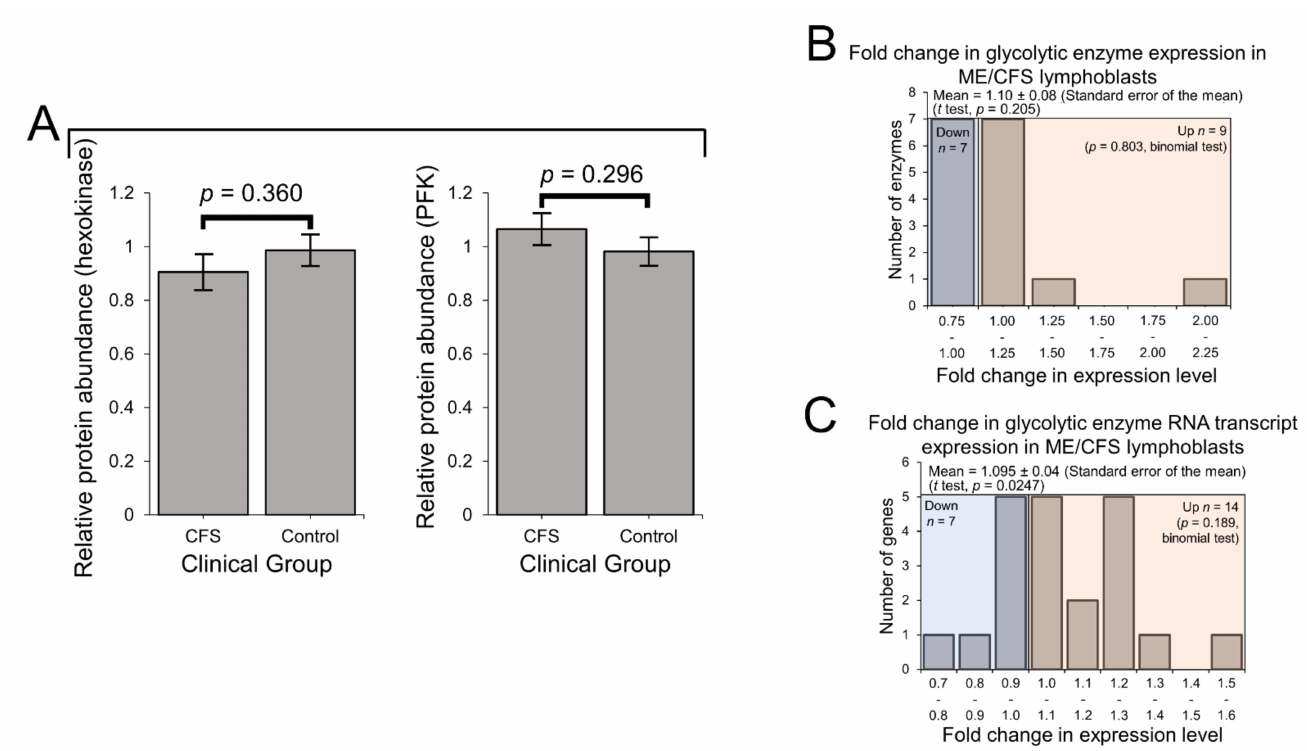
Figure 3. Protein-level expression of glycolytic enzymes is unchanged in Myalgic Encephalomyelitis/Chronic Fatigue Syndrome (ME/CFS) lymphoblasts. Error bars represent the standard errors of the mean. RNA sequencing transcriptomics experiment: ME/CFS n = 23, control n = 17. Each cell line was sampled once. Mass spectrometry proteomics experiment: ME/CFS n = 34, control n = 31. Each cell line was sampled once, or twice for a subset of healthy controls arbitrarily selected to act as an internal control between experiments in the proteomics work. ( A ) The expression level of hexokinase and phosphofructokinase is unchanged in whole-cell mass spectrometry proteomics experiments (independent t test ). Relative hexokinase (HK) and phosphofructokinase (PFK) abundance was calculated by averaging the mean fold change in the ME/CFS group for each isoenzyme/subunit of the respective enzyme (none of which were statistically significant on their own, threshold p < 0.05). ( B ) A total of 16 glycolytic enzymes were detected within the whole-cell proteomes of lymphoblasts from ME/CFS and control lymphoblasts. Fold change refers to the mean abundance of a given protein in the CFS group divided by the mean abundance in the control group. There was no significant difference in the differentially expressed proportions of detected glycolytic enzymes (binomial test with H o set to 0.5) or the magnitude of expression (single-sample t test with H o m = 1) between ME/CFS and controls. ( C ) A total of 21 RNA transcripts encoding glycolytic enzymes were detected by RNA sequencing within the whole-cell transcriptomes of ME/CFS and control lymphoblasts. Mean fold change was calculated for the ME/CFS group versus the control average for each transcript. The proportion of detected transcripts that were upregulated (binomial test with H o set to 0.5) was not significant while the average extent of the upregulation (single-sample t test with H o m = 1) was statistically